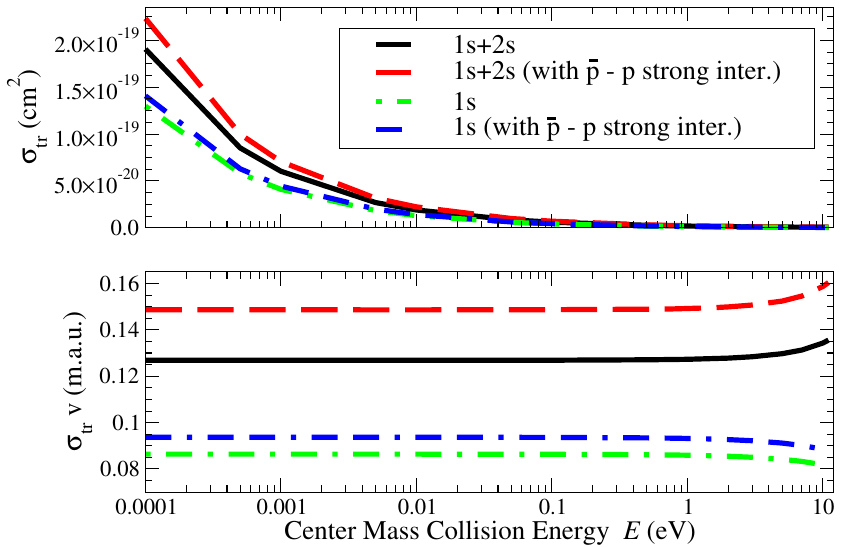
Figure 4. Upper plot: integral cross sections σ tr in the reaction (3) with and without inclusion of the ¯p-p strong interaction. Only the 1 s and 1 s + 2 s approximations are used. Lower plot: corresponding results as on the top plot, but for the low-energy reaction rate: σ tr multiplied by the collision velocity v = v c . m .